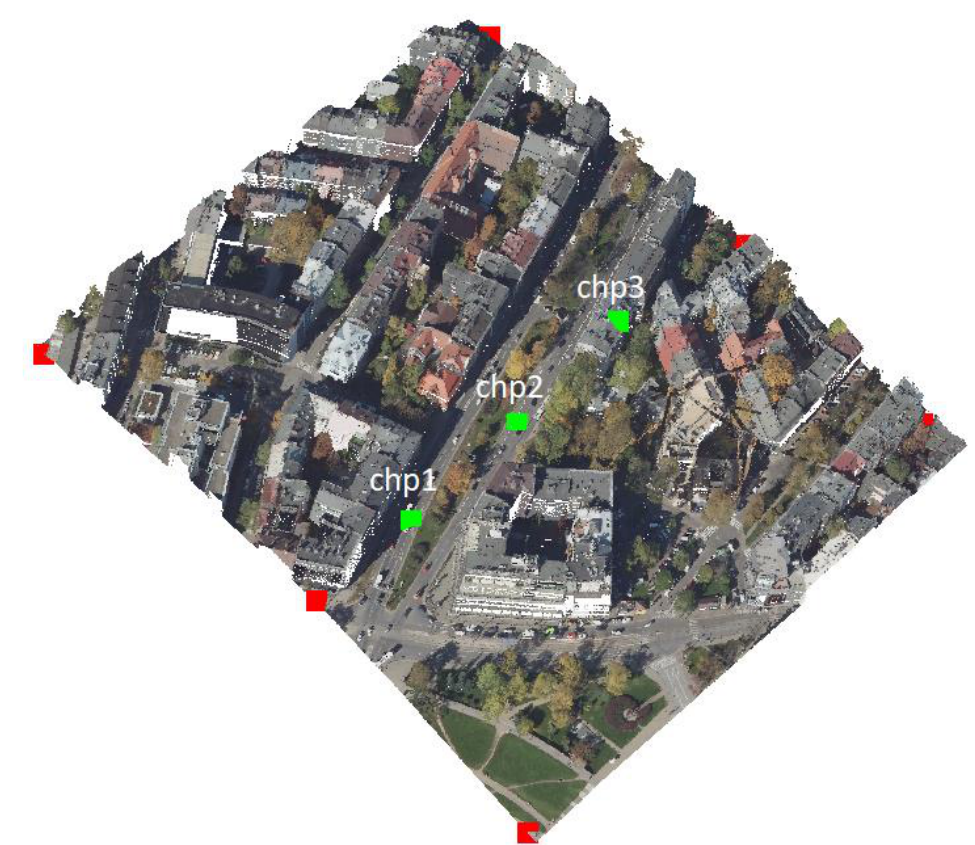
Figure 13. Two strips of real data of Krakow centre, with six red GCPs and three green check points. Table 6. Height discrepancies of check points between strips of real data.